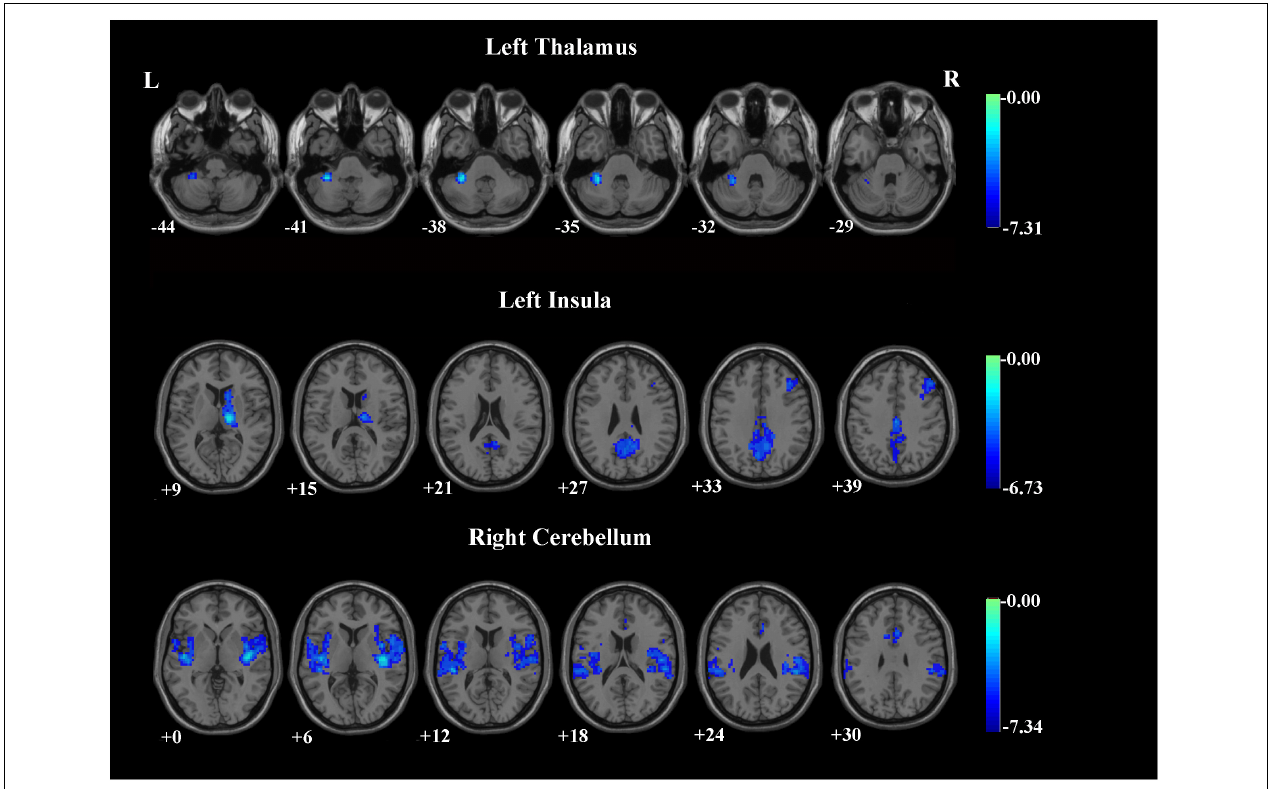
FIGURE 1 | Brain regions demonstrating group differences of the iFC between SN subregions and whole brain voxels in patients with OCD. The threshold was set at a voxel p -value < 0.001 and a cluster p -value < 0.00263, two-tailed (Bonferroni corrected using the GRF method). L, left side; R, right side.